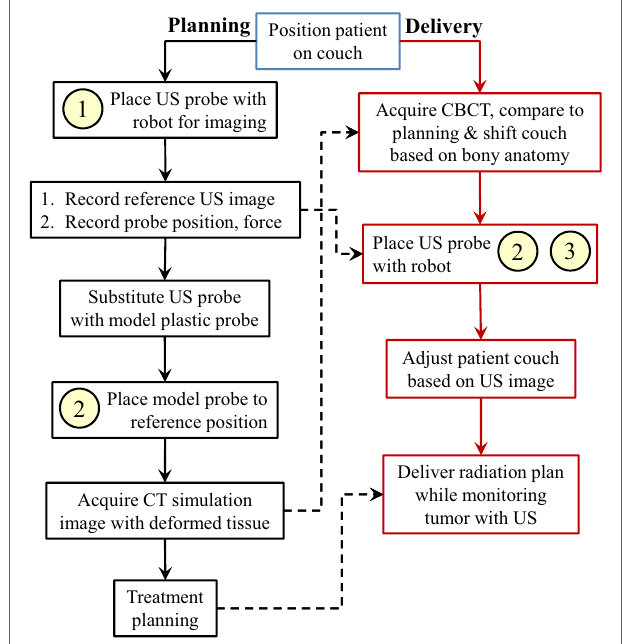
FIGURE 2 | Proposed robotic-assisted ultrasound-guided IGRT workflow, showing use of (1) unconstrained cooperative control, (2) static virtual fixtures, and (3) dynamic virtual fixtures . Box (1) is performed by expert sonographers, and boxes (2) and (3) are performed by therapists. The dashed arrows represent data transferred from the planning day to the delivery